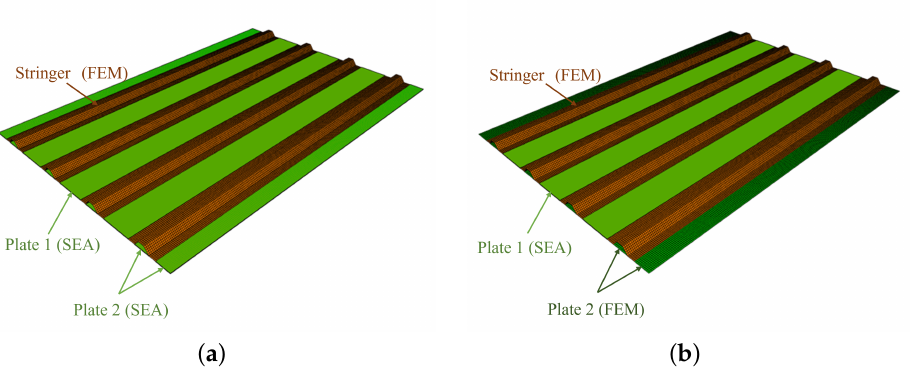
Figure 17. VAOne Hybrid models: ( a ) Hybrid 2D (1) and ( b ) Hybrid 2D (2).